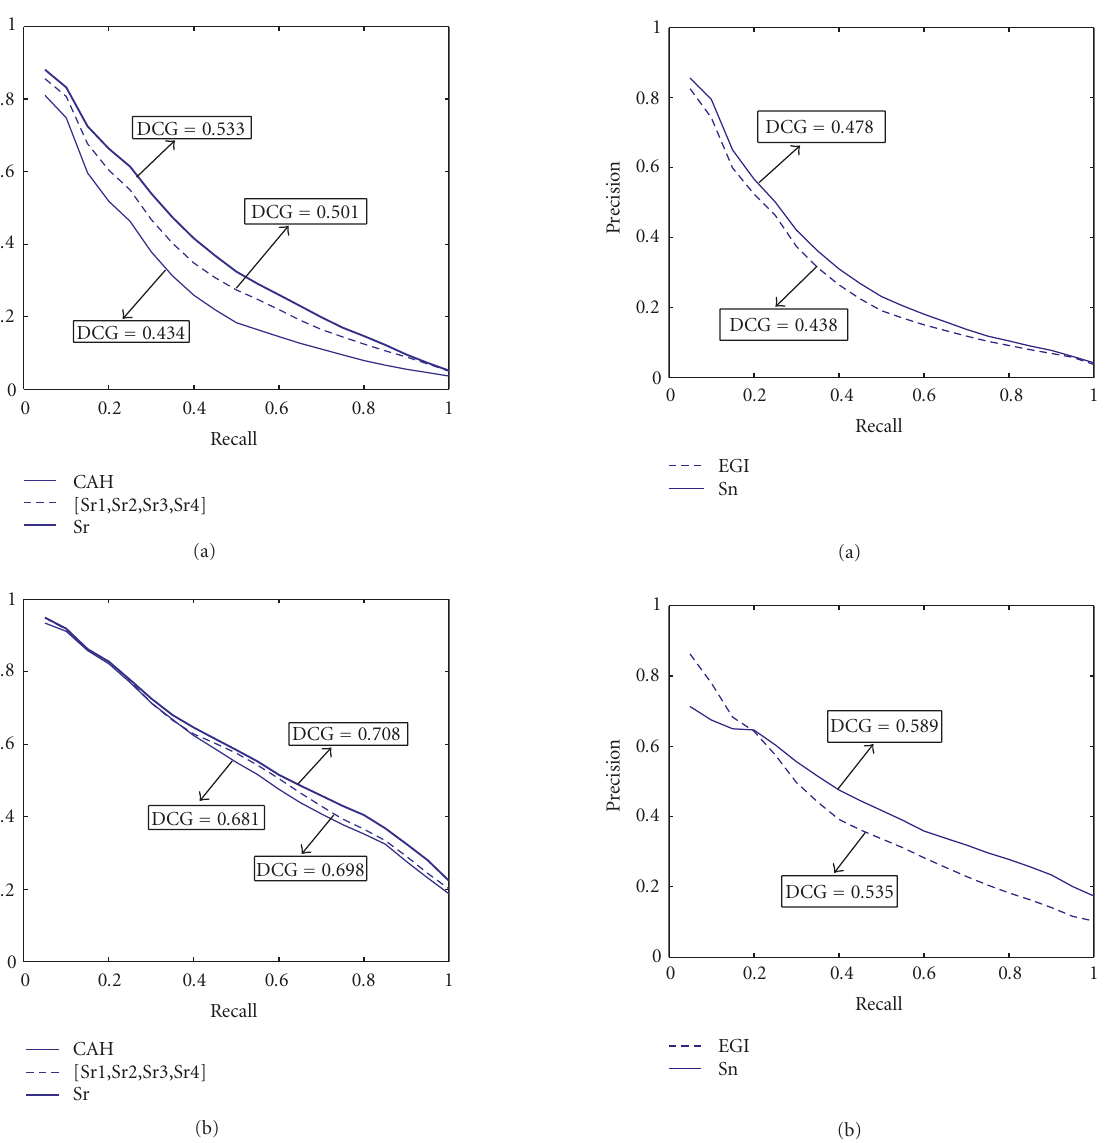
Figure 9: Precision-recall curves for EGI and Sn on PSB test set (a) and SCUdb